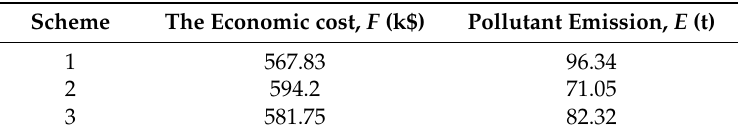
Table 3. Results of three scheduling schemes.